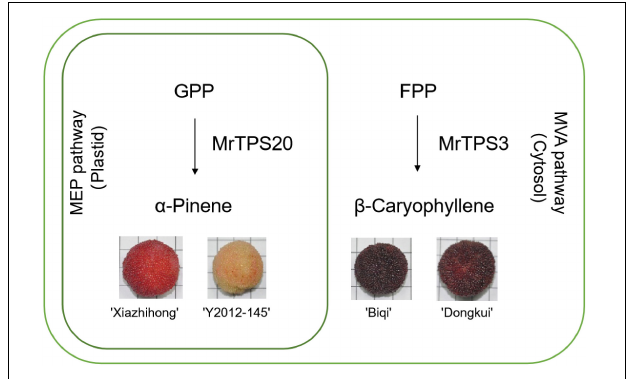
FIGURE 7 | Summary of terpenoid biosynthesis in the four red bayberry cultivars. The outer green circle indicates a cell while the inner green circle indicates the plastid. ‘Xiazhihong’ and ‘Y2012-145’ mainly produce α -pinene in plastid, for which MrTPS20 is responsible. ‘Biqi’ and ‘Dongkui’ mainly produce β -caryophyllene in cytoplasm, for which MrTPS3 is